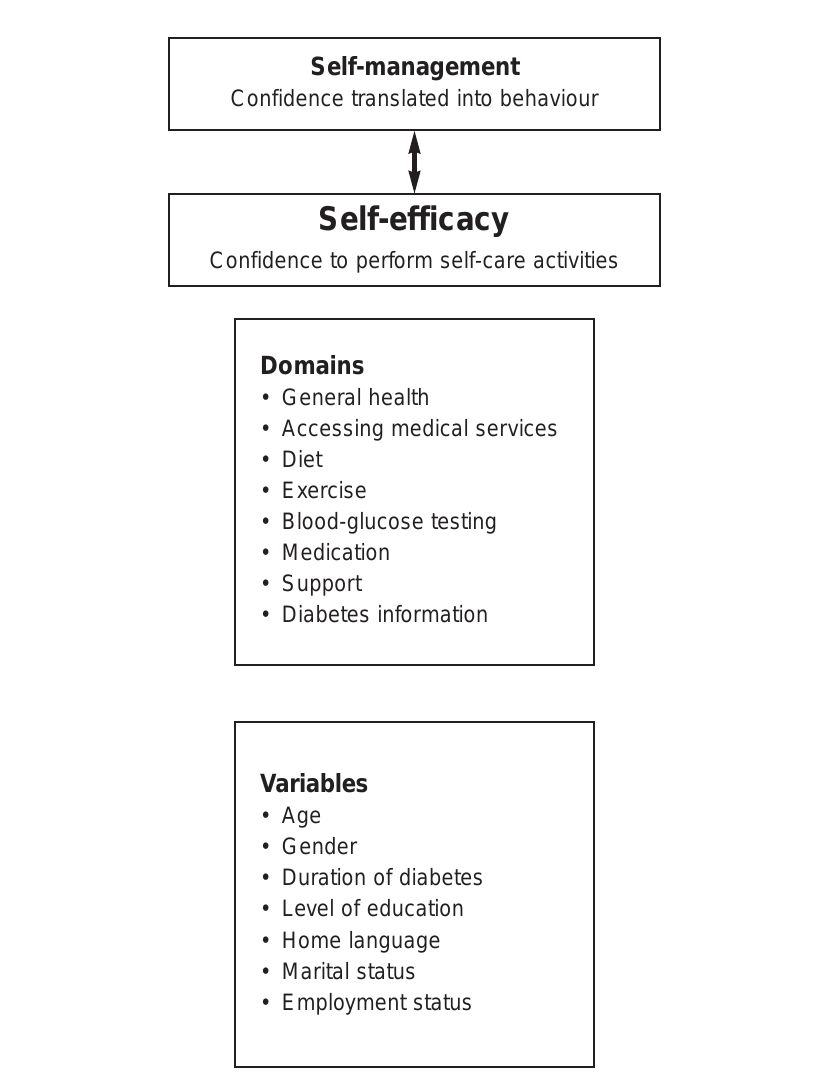
Figure 1: Self-efficacy and factors influencing it, in relation to self-